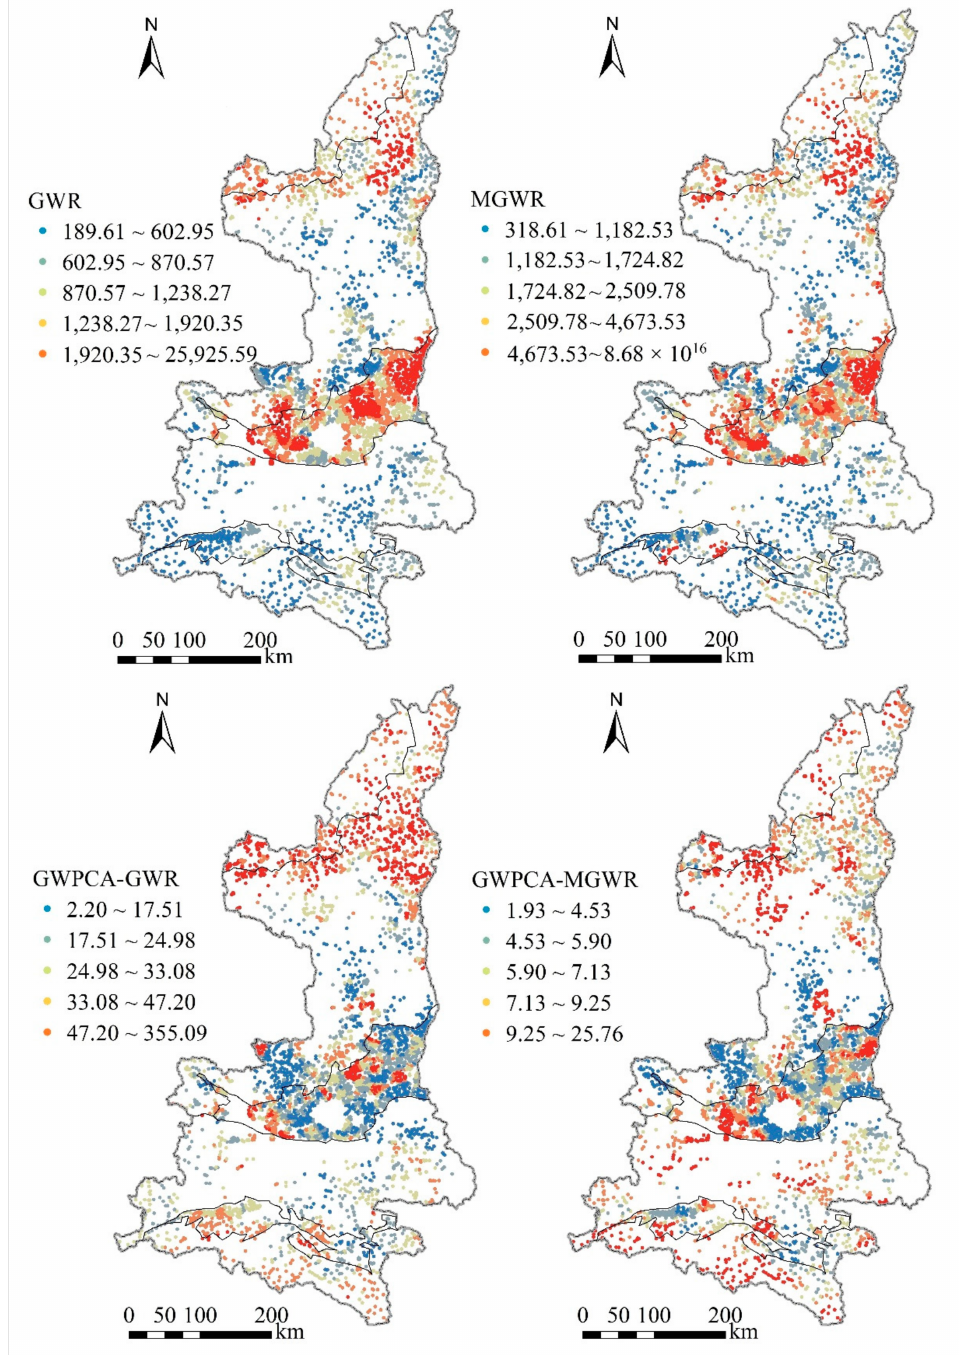
Figure 5. The spatial distribution of local CN. Second, GWR and MGWR are unlikely to be robust due to the obvious unreason- ableness in that only the regression coefficients of STN and C/N ratio are significant for most samples. However, the number of regression coefficients with significant correlation at the 0.05 level increased significantly after GWPCA was employed. Among them, the concentration and number of correlation coefficients between the intercept and